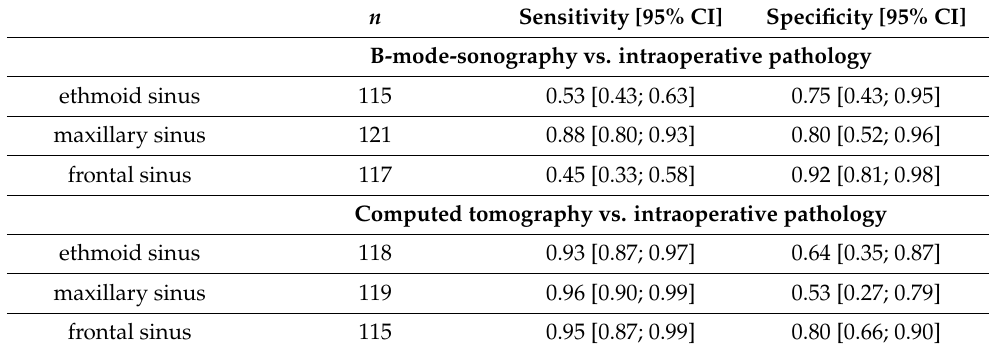
Sensitivity and specificity of sonography and CT scan compared with findings obtained during surgery. A partial mucosal swelling or secretion retention was defined as a positive finding. The 95% confidence interval (CI)